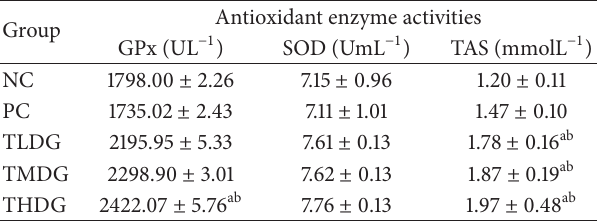
Table 5: Effect C. betacea extract on antioxidant enzyme